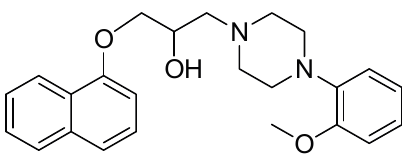
Figure 1. Structure of